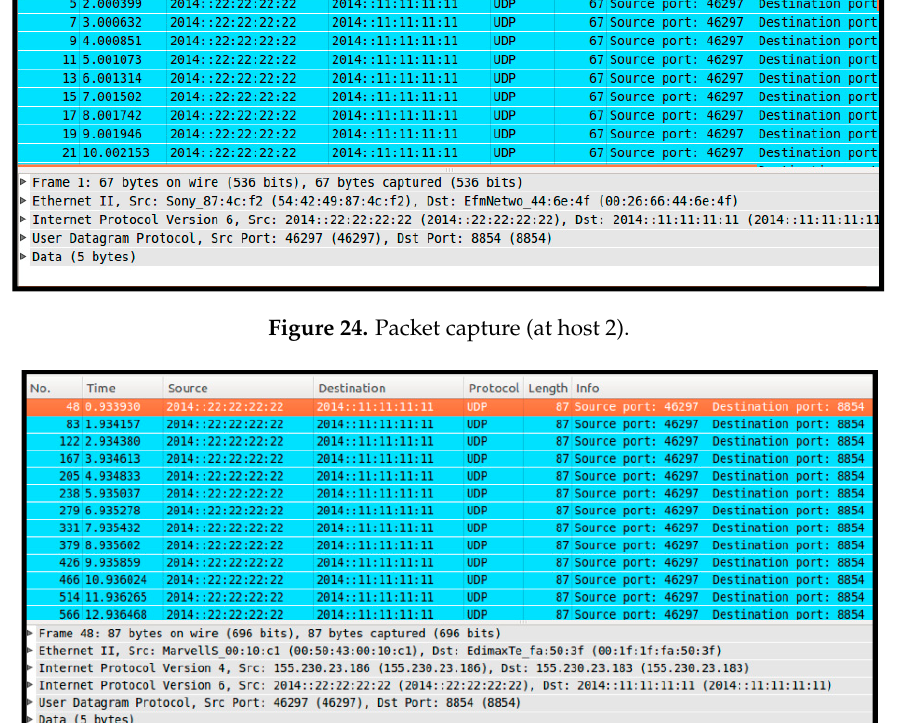
Figure 25. Packet capture (at the R ‐ GW of domain 1).